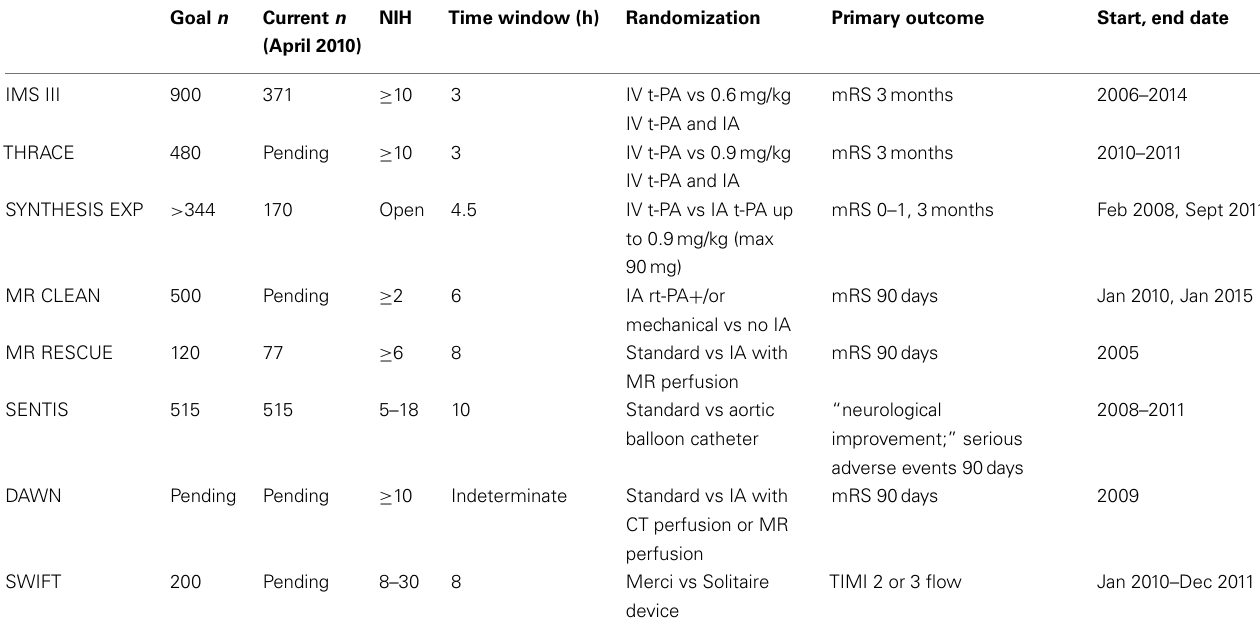
Table 2 | Current randomized